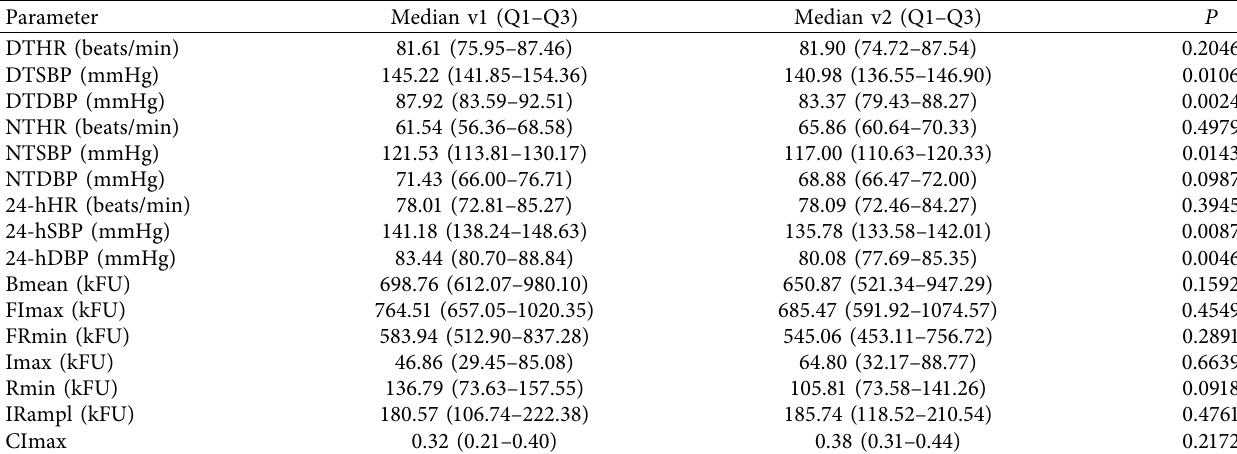
Table 2: Summary of continuous measures for hypertensive patients assigned to amlodipine at 5 mg QD. P values of the paired analysis of continuous data with a nonparametric Wilcoxon test for comparison of results before and after the six-week treatment.